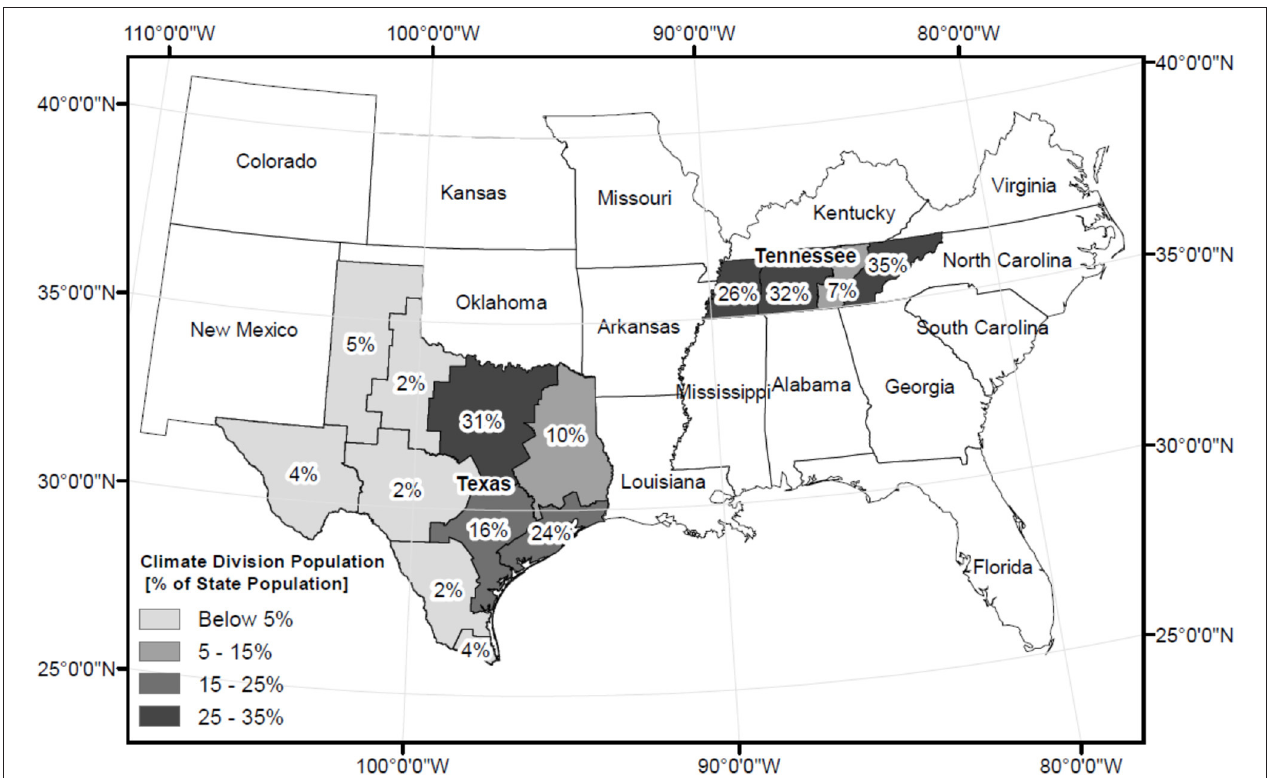
FIGURE 1 | Map of the climate divisions in Tennessee and Texas. The color of the climate division indicates the average percentage of the state population in each climate division for the timeframe of this study. Darker colors represent a higher percentage.